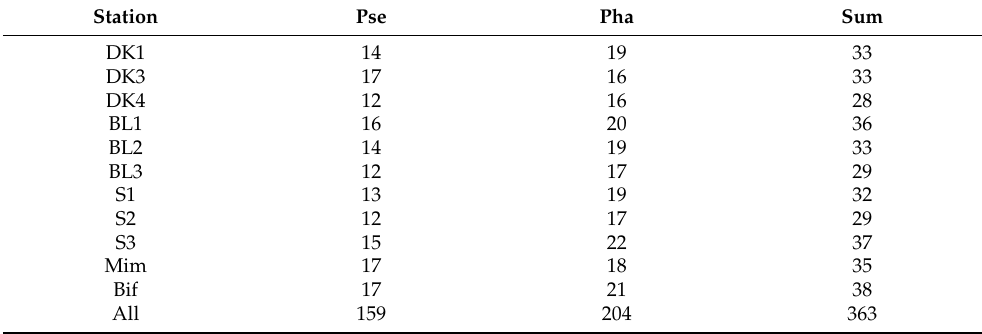
Table 4. Summary of the number of blooms detected by stations for the two species, Phaeocystis globosa (Pha) and the complex Pseudo-nitzchia (Pse). For station locations, see Figure